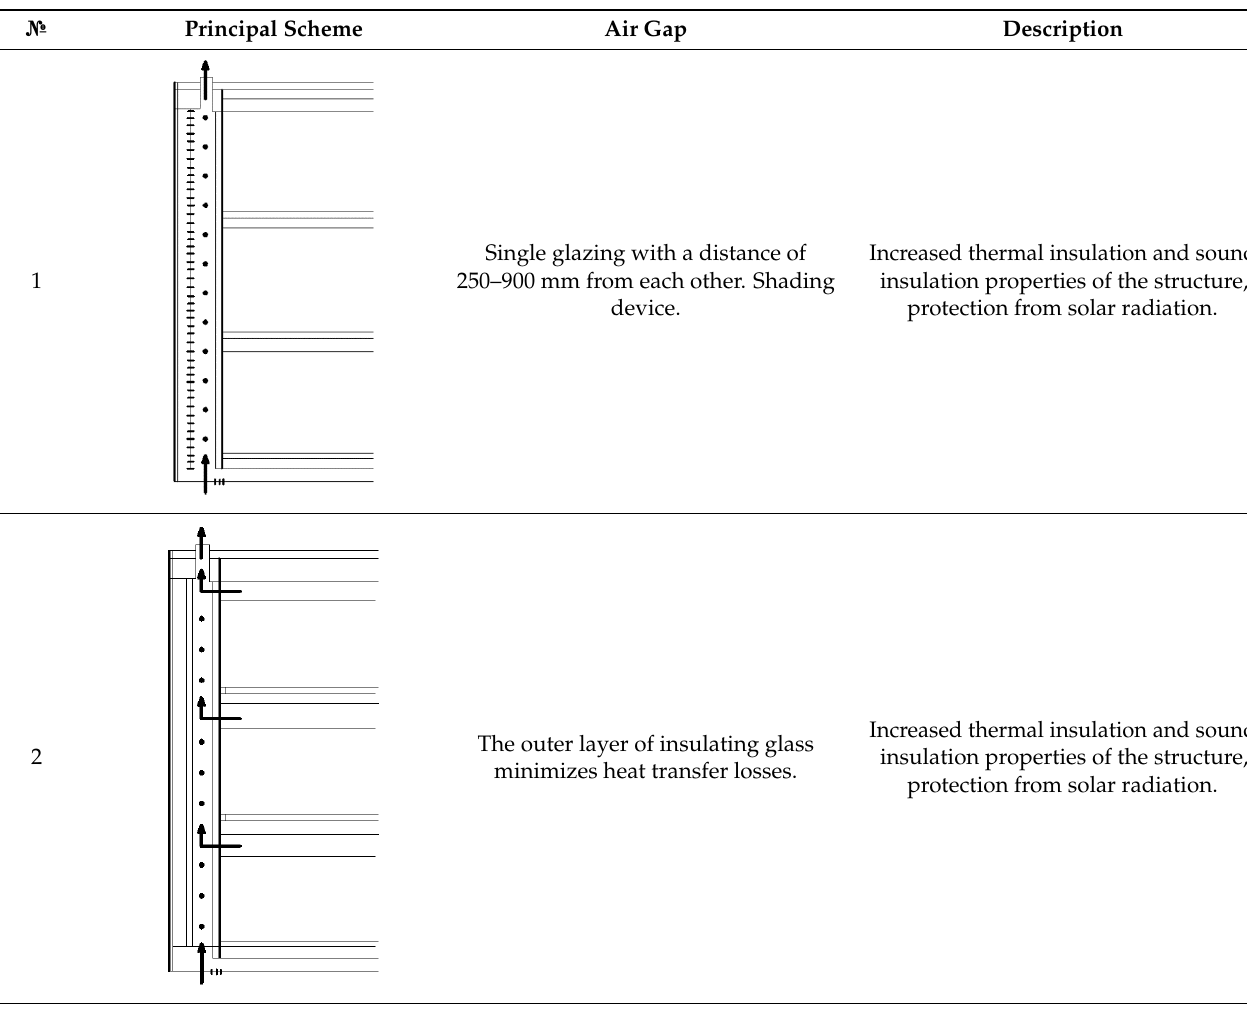
Table 3. Types of multi-skin ventilated facades.